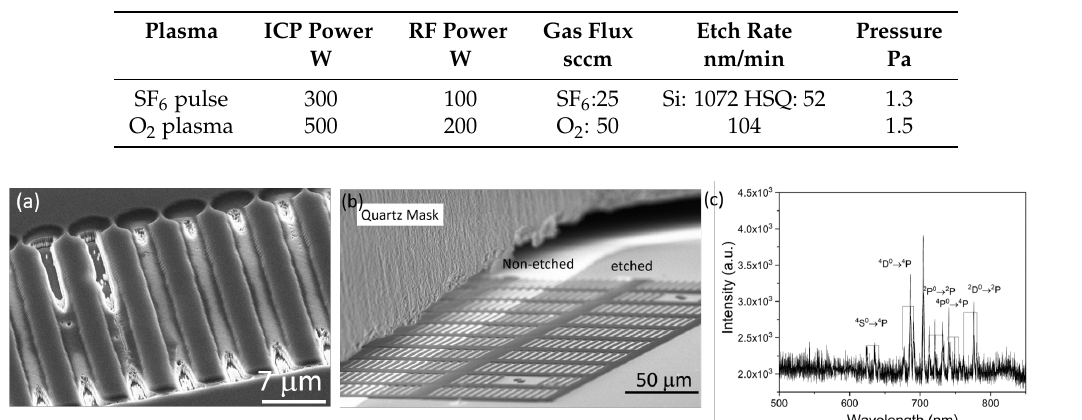
Table 1. Etching plasma parameters. SF 6 pulse used to selectively remove the evaporated silicon layer (5 s including plasma ignition step). The O 2 plasma is subsequently used as an anisotropic etch for SCD to form the platforms as well as the pillars (10–15 min etching time).